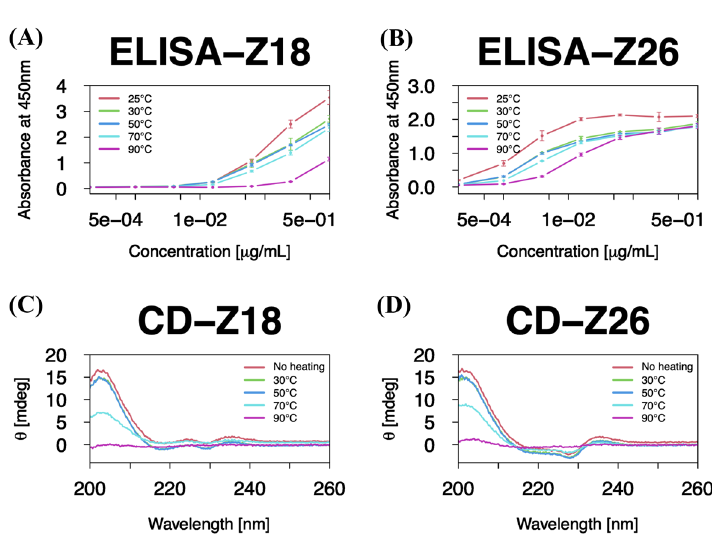
Figure 2. Binding capabilities and secondary structures of the single-domain V H H antibodies show similar trends between Z18 and Z26. ( A , B ) ELISA to quantify binding of ( A ) Z18 and ( B ) Z26 to HSA. ELISA was independently repeated three times, and the average values were plotted with the standard deviations. ( C , D ) CD spectra of ( C ) Z18 and ( D ) Z26. CD measurements were performed with 0.15 mg/mL of a sample in PBS. All graphs in this article were made by R packages 41